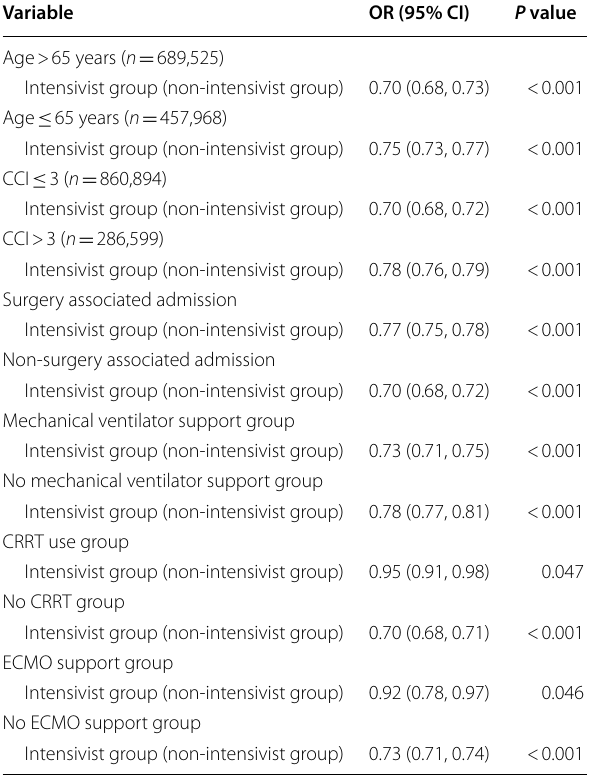
Table 4 Subgroup analyses for in‑hospital